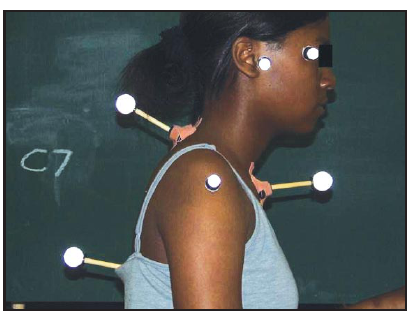
Figure 3: Model posture at 10 minutes